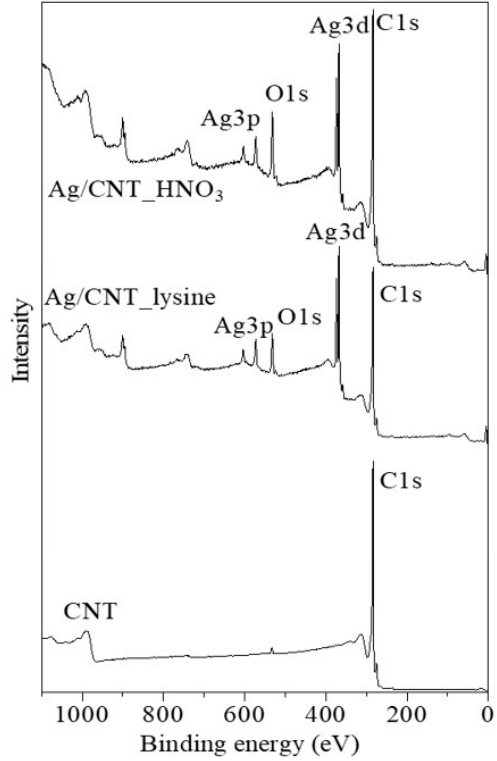
Figure 5. XPS survey spectrum of the AgNP/MWCNT nanocomposites.